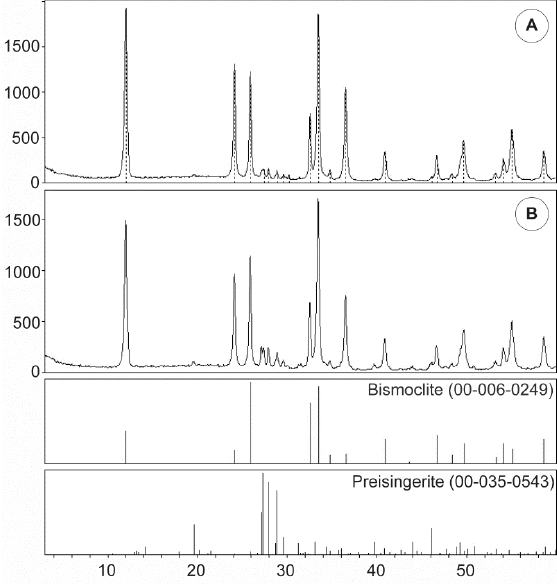
Figure 3. Bismoclite’s oriented X-ray diffractograms (above) and reference non–oriented reflection data (below). ( A ) Bismoclite with traces of preisingerite. Note that the first reflection corresponding to (001) plane, is 2.5 times more intense than the 00-006-0249 reference data. In a similar manner, the intensity of the second reflection (002), as well as the seventh peak (003), are 3.9 and 3.2 times stronger, respectively, than the reference pattern. ( B ) Bismoclite with minor preisingerite. Note the four most intense reflections of preisingerite grouped between 27° and 30°.